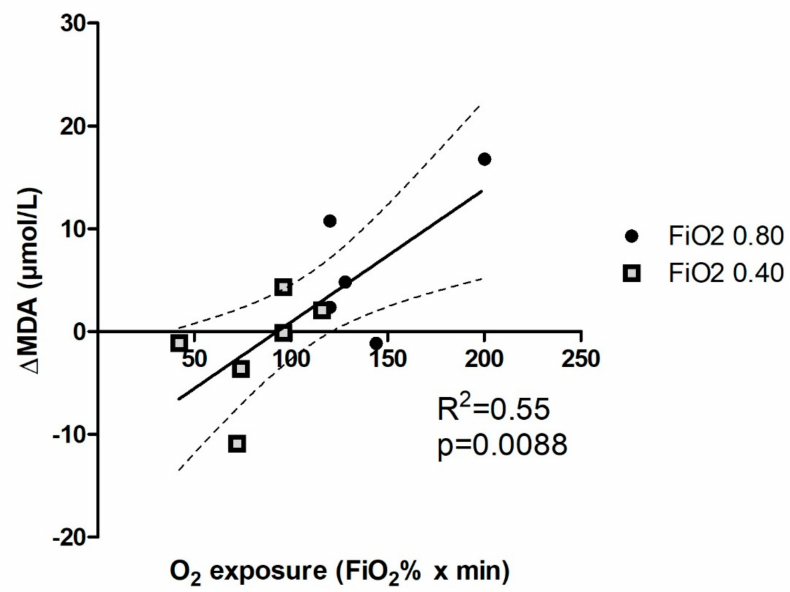
Figure 4. Scatter plot of MDA production at 24 h as function of the O 2 exposure. O 2 exposure was calculated as the product of FiO 2 and the surgery running time. Solid line: linear regression line. Dotted lines: 95% confidence